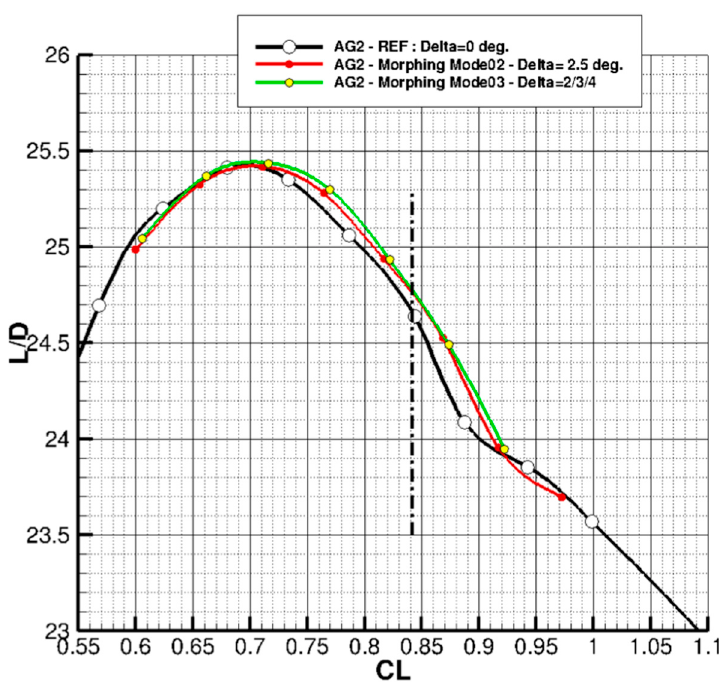
Figure 3. Performance of the multifunctional trailing-edge.